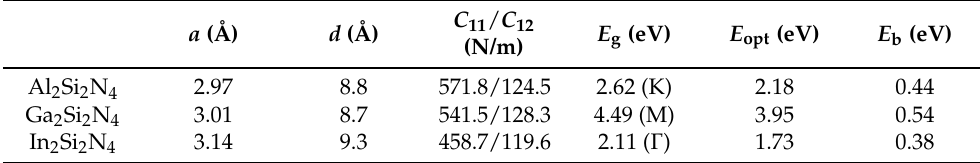
Table 1. The calculated lattice constant a , thickness d , elastic constants C 11 / C 12 , energy gap E g , optical gap E opt and exciton binding energy E b from GW-BSE methods for M 2 Si 2 N 4 monolayers. a